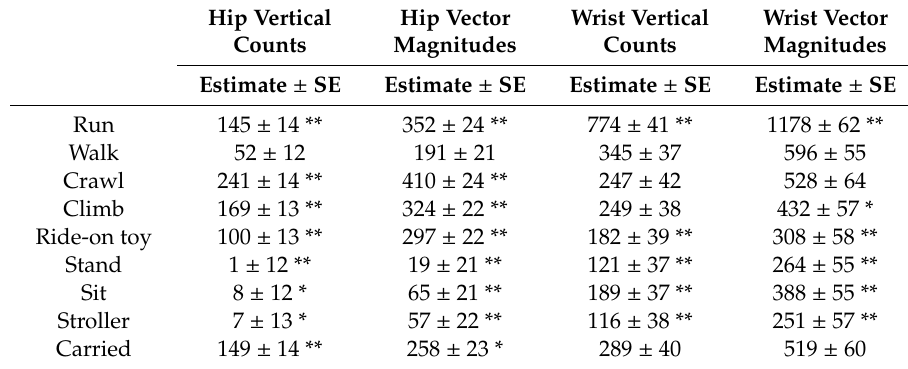
Table 2. Least square means of vertical counts and vector magnitudes for the nine behavior types among toddlers.